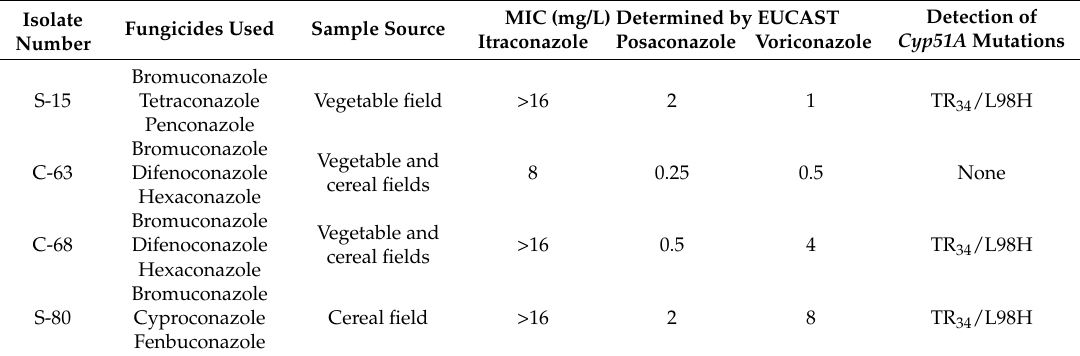
Table 2. Results of susceptibility testing performed by broth microdilution (EUCAST) and analysis of cyp51A mutations for four azole-resistant A. fumigatus sensu stricto